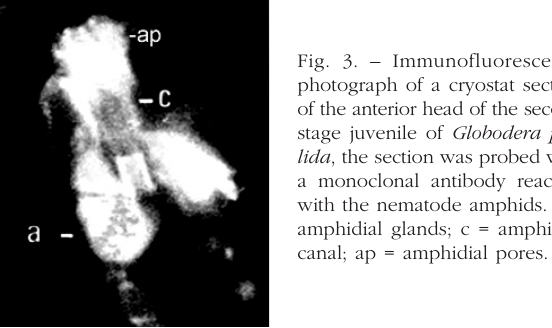
Fig. 3. – Immunofluorescence photograph of a cryostat section of the anterior head of the second stage juvenile of Globodera pal- lida , the section was probed with a monoclonal antibody reactive with the nematode amphids. a = amphidial glands; c = amphidial canal; ap = amphidial